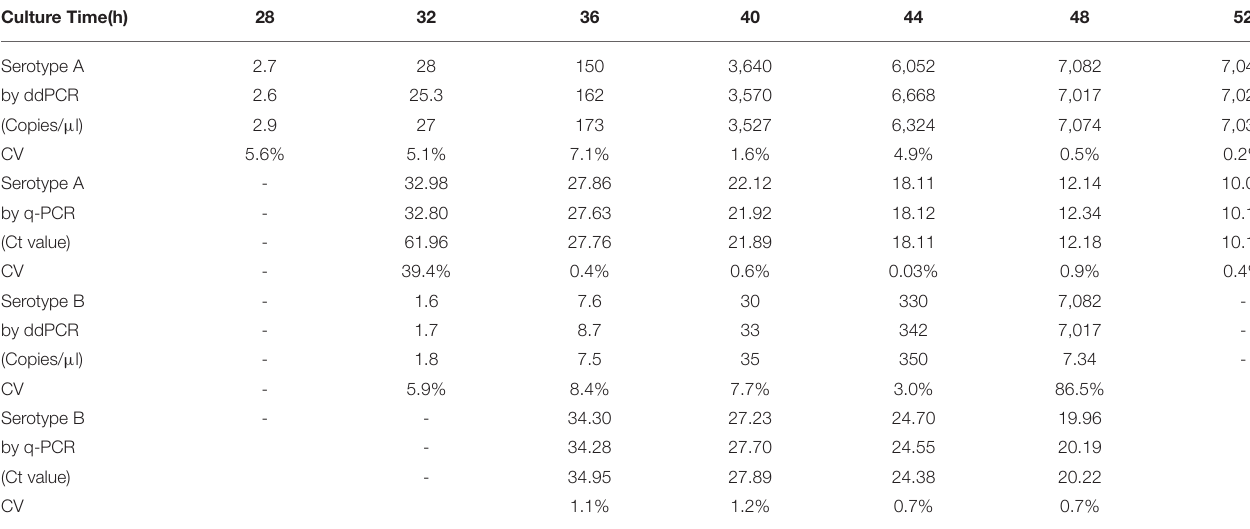
TABLE 5 | The growth of serotypes A and B strains in enrichment culture with 100 spores inoculation detected by ddPCR and q-PCR. Culture